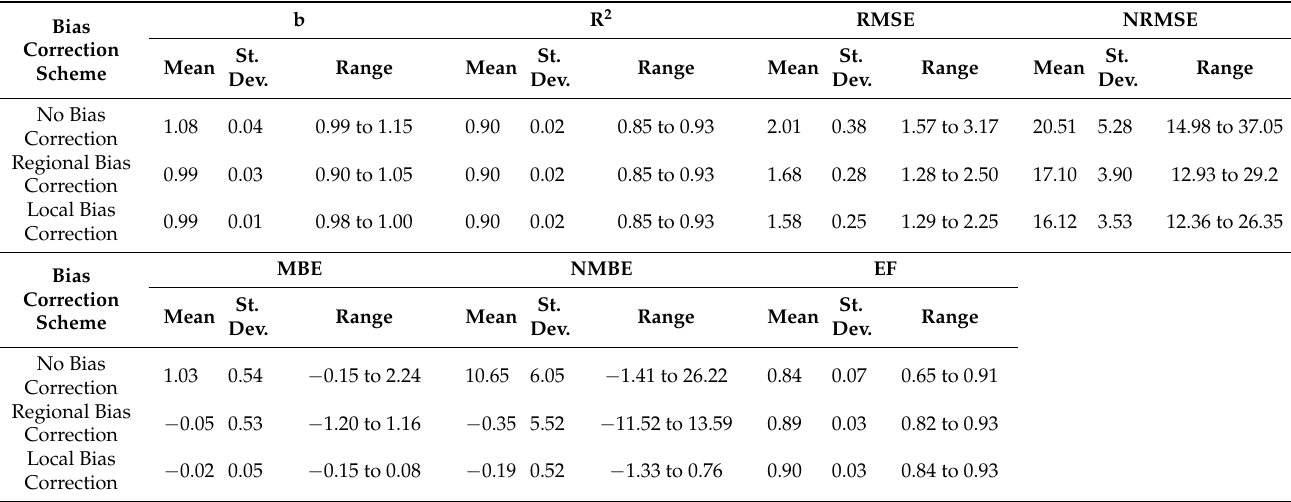
Table 5. Mean and range values of the accuracy metrics relative to NASA POWER minimum temperature with and without bias correction for the full data set of all 14 locations.